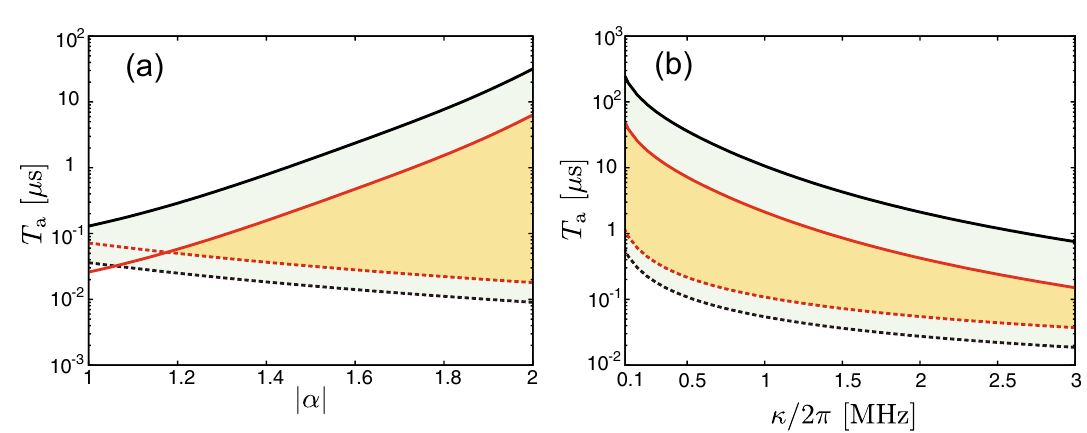
ρ est ( t , T a ) , ρ c ( t ) [ ( U ) 0.95